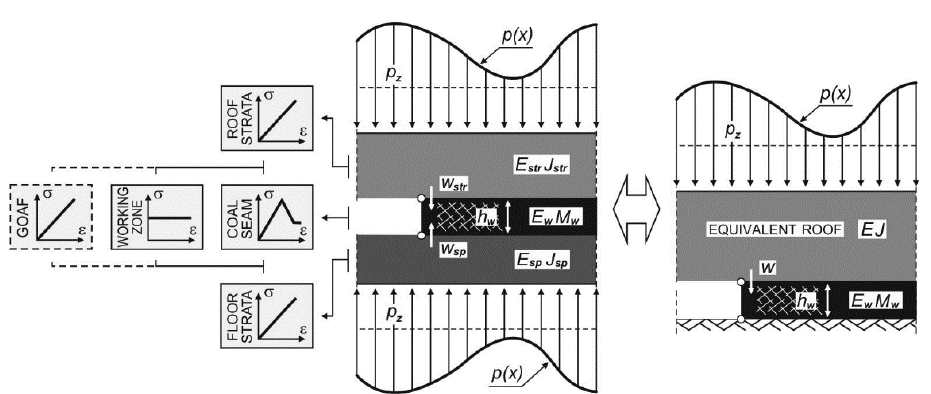
Figure 2. Geomechanical model of the rock strata.